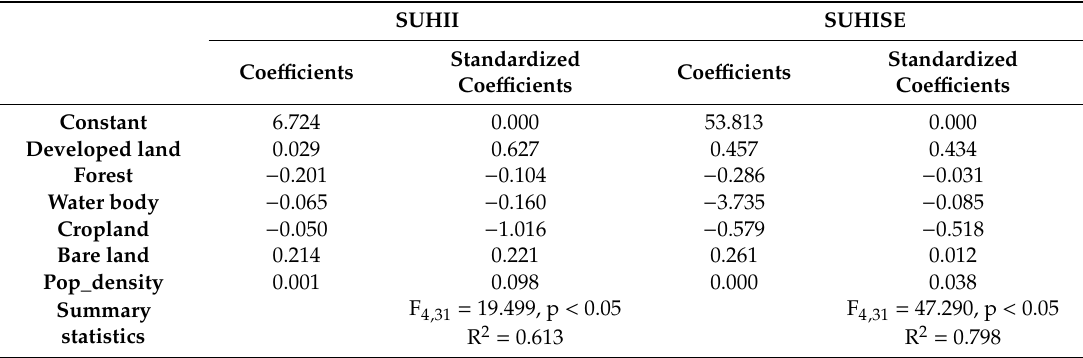
Table 3. Coe ffi cients of partial least squares regression (PLSR) models for summertime SUHII and SUHISE versus the independent